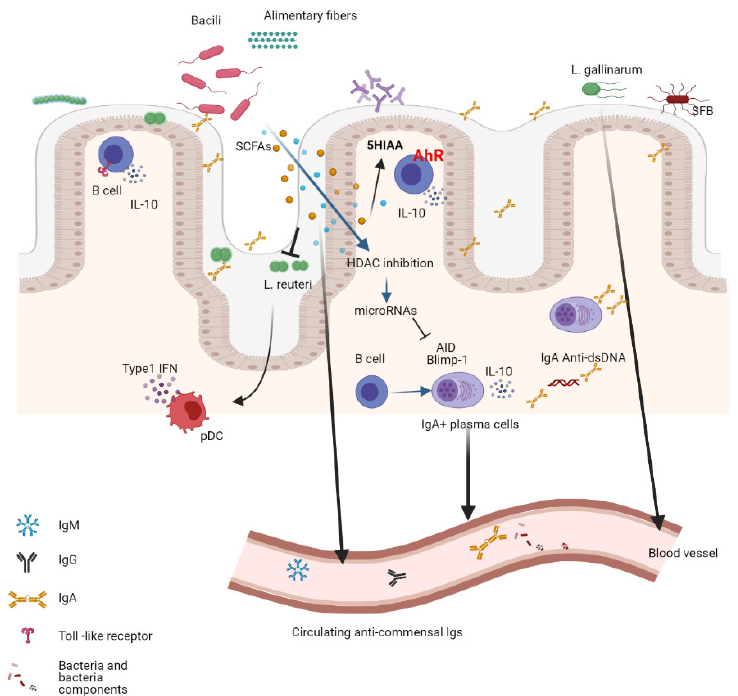
Figure 2. Resident intestinal commensals modulate the local and systemic immune response. Bacterial components trigger the humoral response within the GALT and also systemically when they move into circulation. Similarly, the metabolites produced by bacteria (SCFA)